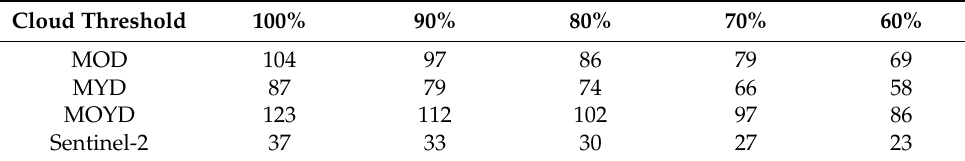
Table 1. Number of available snow-cover maps and the impact of the selected cloud threshold on data availability of MODIS and Sentinel-2 snow-cover maps. For the MODIS data sets, the snow threshold of 5% was applied additionally, whereas for the Sentinel-2 snow-cover data set, only cloud thresholds were applied to calculate the number of